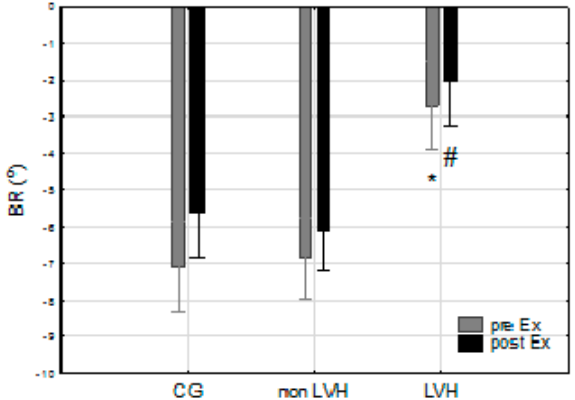
Figure 2. Basal rotation (BR) at rest (Rest) and after maximal exercise (Post-Ex) in the CG, among cyclists without ventricular hypertrophy (non-LVH) and with LVH. * p < 0.05 LVH max vs CG max; # p < 0.05 LVH vs non-LVH.